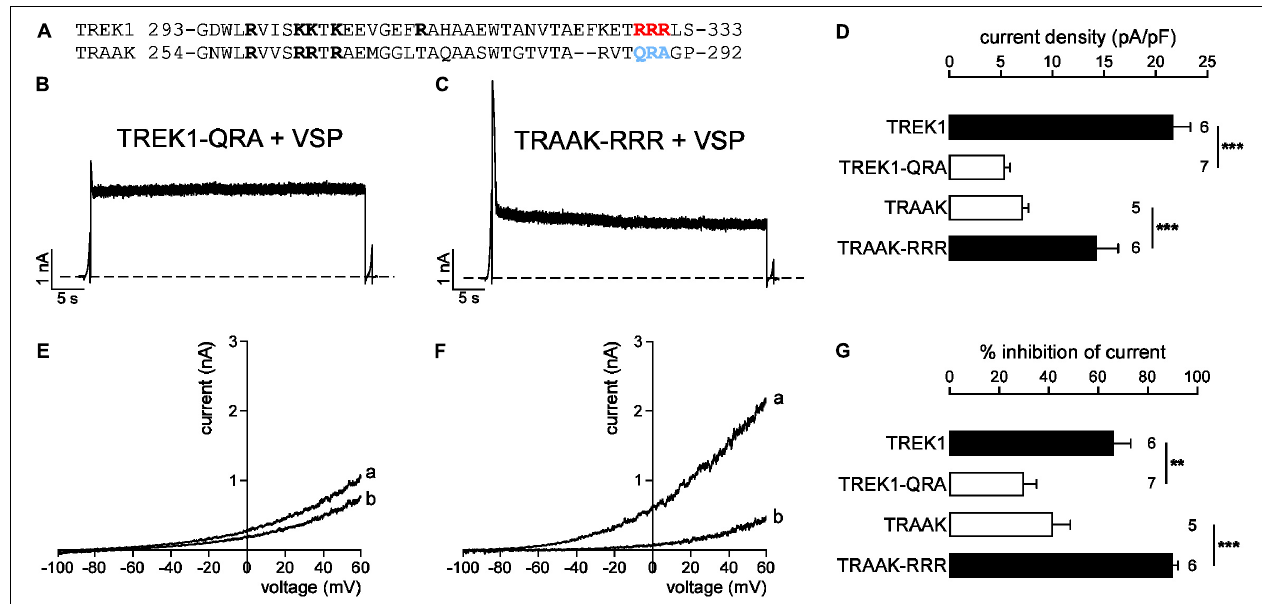
FIGURE 8 | Sensitivity to PIP 2 is modulated by a cluster of basic residues in pCt. (A) Sequence alignment of TREK1 and TRAAK pCt. In red and blue the residues that are swapped in TREK1-QRA and TRAAK-RRR. (B,C) Representative perforated patch-clamp recordings from HEK cells co-expressing VSP and TREK1-QRA (B) and TRAAK-RRR (C) . Same protocol as in Figures 6A , 7A . (D) Current density (%) at 0 mV. (E,F) TREK1-QRA (E) and TRAAK-RRR (F) currents before (a) and after (b) the +120 mV/40 s depolarizing pulse. (G) Current inhibition (%) at 0 mV. (D,G) Data are presented as mean ± SEM. ∗∗ p < 0.01, ∗∗∗ p < 0.001, the number of cells is indicated (Student’s t